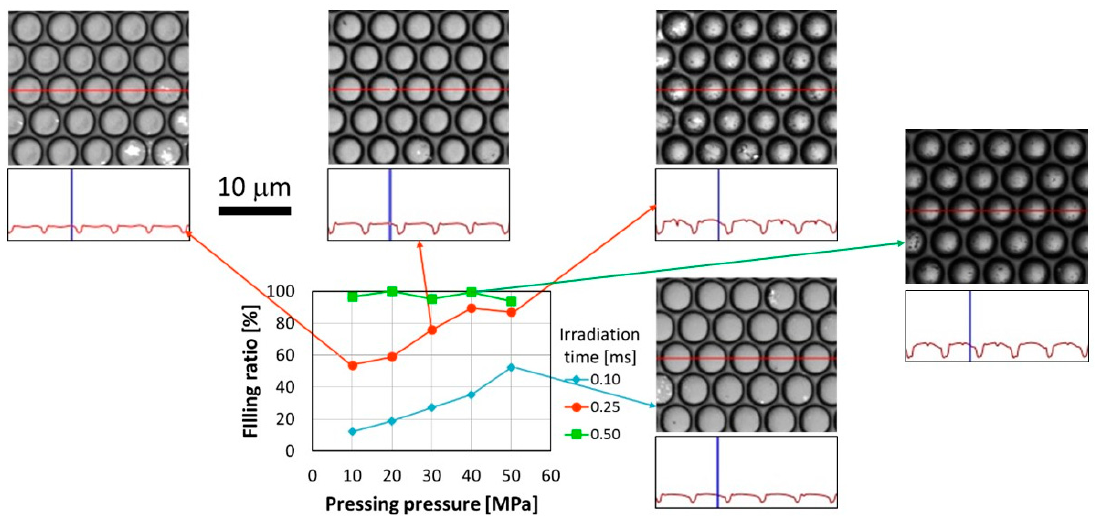
Figure 5. Filling ratio as a function of pressing pressure for each irradiation time in the replication of the 5- μ m-pitch MLA.